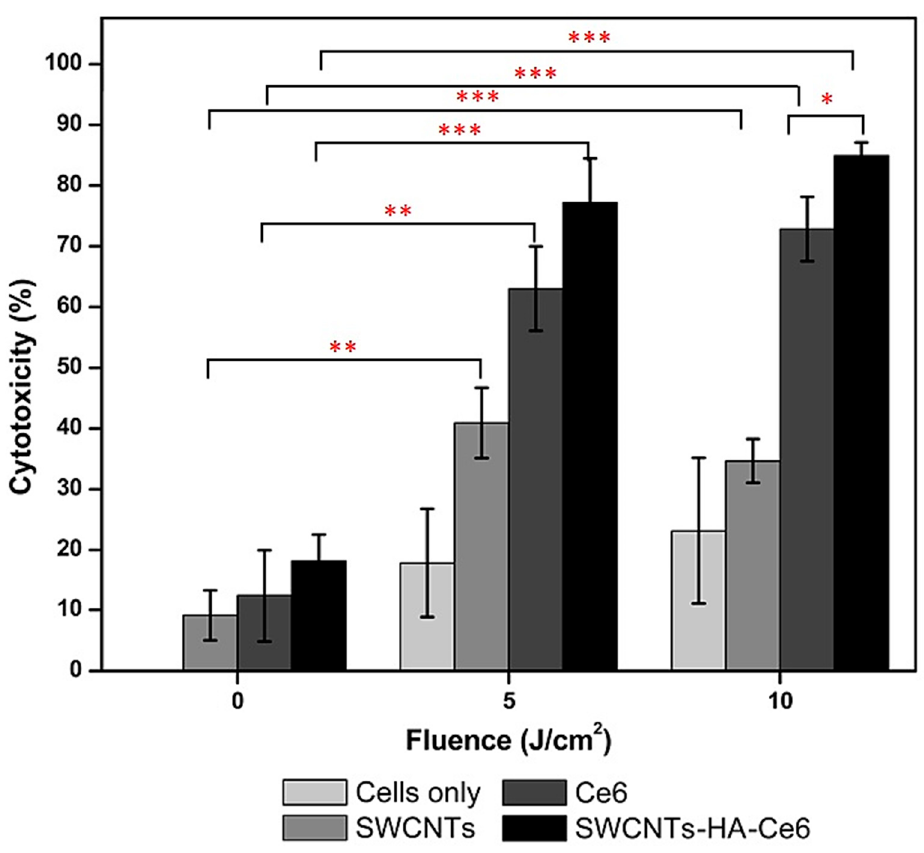
Figure 6. The cytotoxicity effects of SWCNTs, Ce6, SWCNTs-HA-Ce6 on Caco-2 cells determined by LDH assay. Significance is shown as * p < 0.05; ** p < 0.01; *** p <